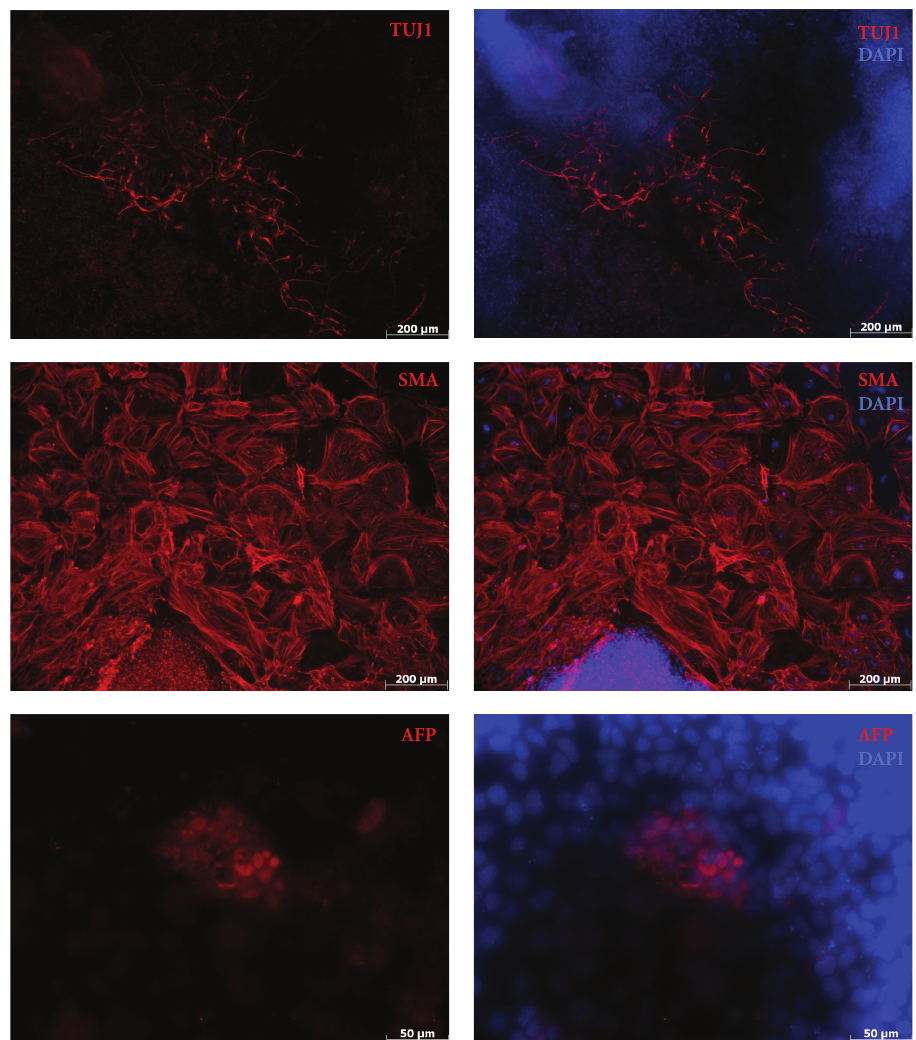
Figure 5: In vitro di ff erentiation of Sox2-piPS cells. Spontaneously di ff erentiated Sox2-piPS cells were stained for β -3-tubulin (TUJ1, ectoderm) smooth muscle actin (SMA, Mesoderm), and α -fetoprotein (AFP, endoderm) as indicated. DAPI co-staining was performed in every